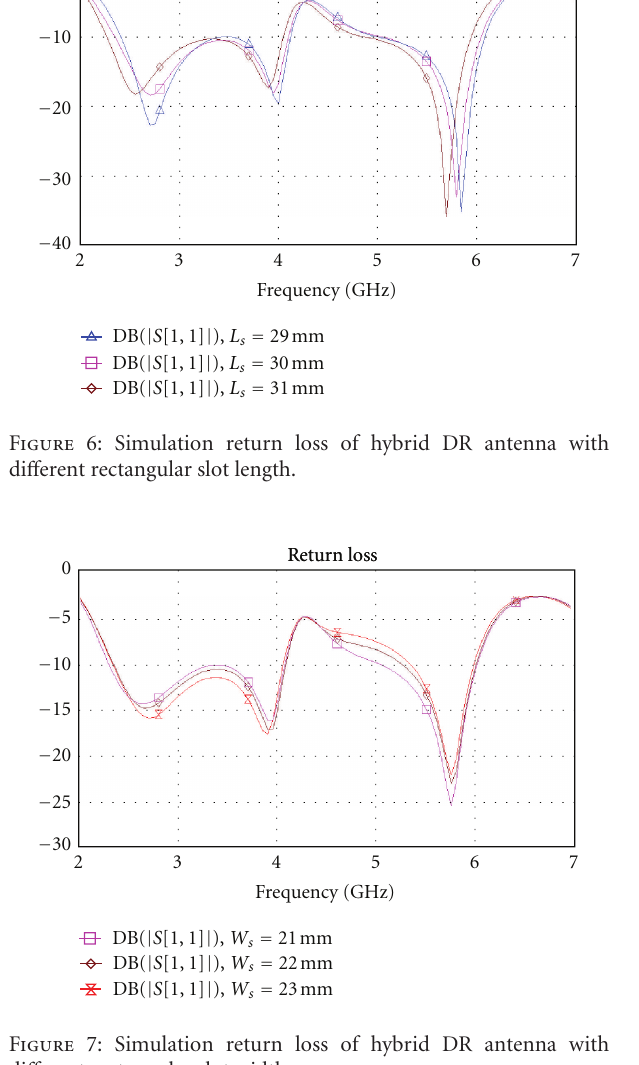
Figure 7: Simulation return loss of hybrid DR antenna with di ff erent rectangular slot width.